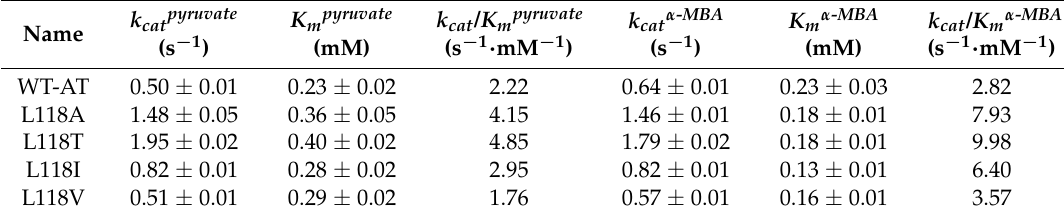
Table 2. The kinetic constants of the wild-type and four stabilized mutant